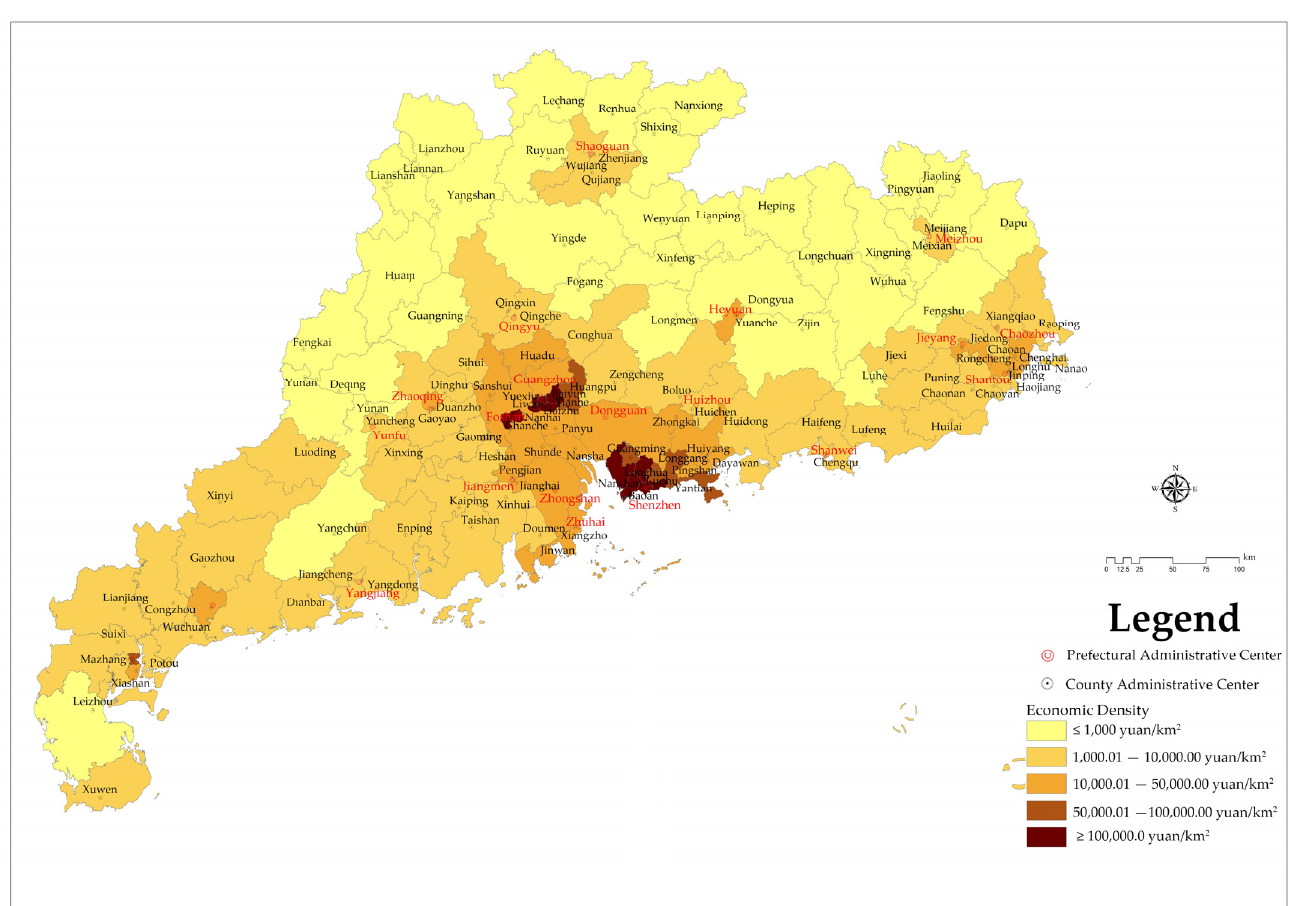
Figure 5. Hierarchical distribution of economic density.